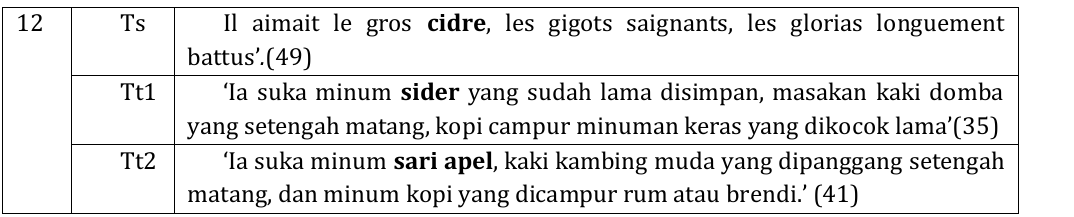
Tableu 12 L’emprunt